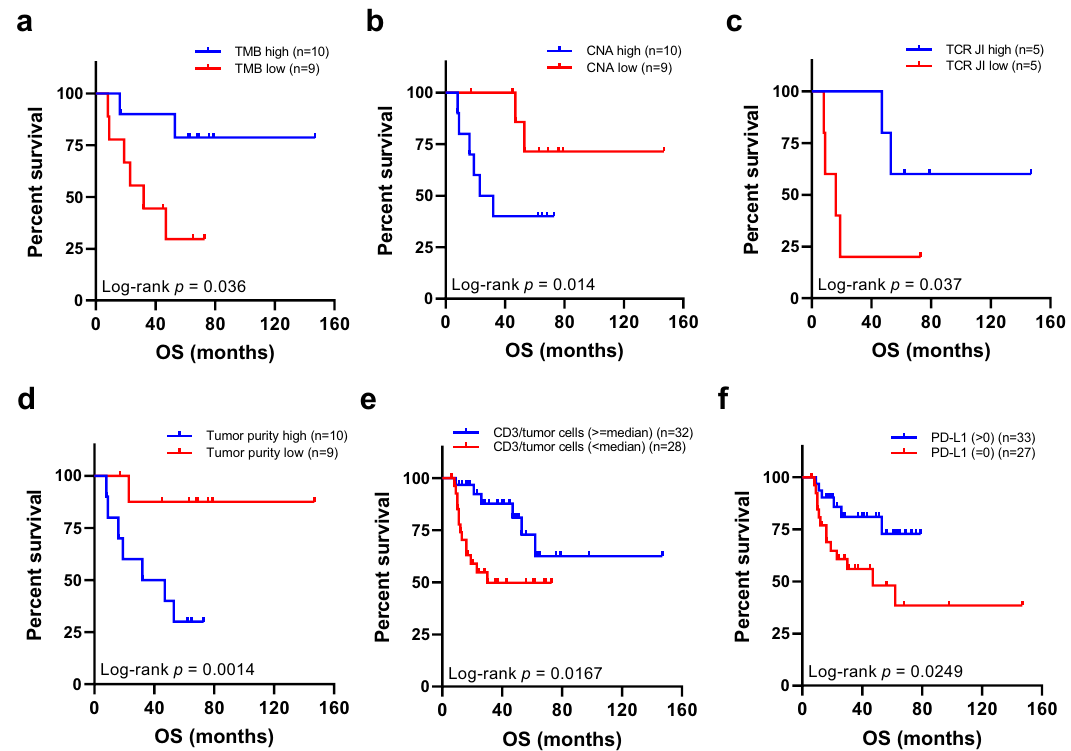
Fig. 7 Association of overall survival (OS) with immunogenomic landscape. a OS of patients with higher (above median, blue) tumor mutational burden (TMB) versus patients with lower (below median, red) TMB. b OS of patients with higher (above median, blue) copy number aberration (CNA) burden versus patients with lower (below median, red) CNA burden. c OS of patients with more homogeneous T-cell receptor (TCR) repertoire (higher above- median TCR Jaccard index (JI), blue) versus patients with more heterogeneous TCR repertoire (lower below-median TCR JI, red). d OS of patients with tumors of higher (above median, blue) tumor purity versus patients with tumors of lower (below median, red) tumor purity. e OS of patients with tumors of higher (no less than median, blue) CD3 + tumor-in fi ltrating lymphocytes (TILs) versus patients with tumors of lower (below median, red) CD3 + TILs. f OS of patients with tumors of positive (above 0, blue) programmed death ligand-1 (PD-L1) expression versus patients with tumors of negative (equal to 0, red) PD-L1 expression. Two-sided log-rank test was used for survival analysis. Source data are provided as a Source Data fi